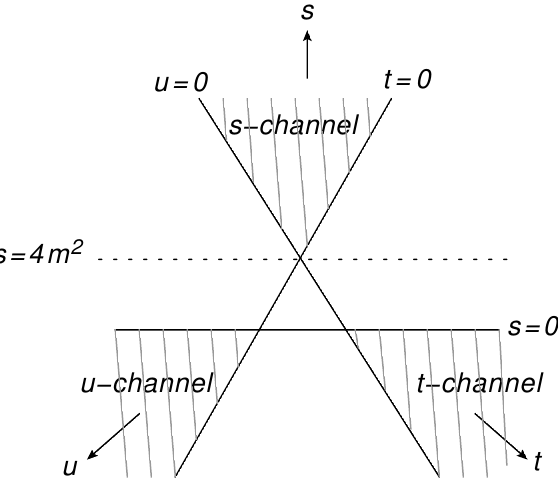
Figure 4: Mandelstam diagram showing the three physical regions of 2 → 2 scatter- ing, in the case where all particle masses are